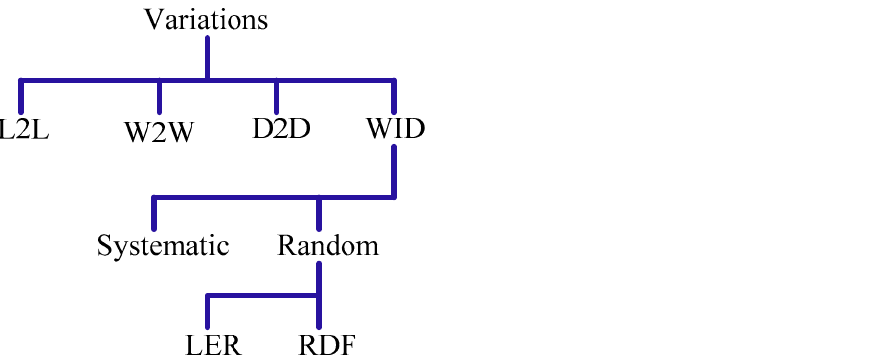
Figure 15. Process variations in the deep sub-Micron and FinFETs [8,52].